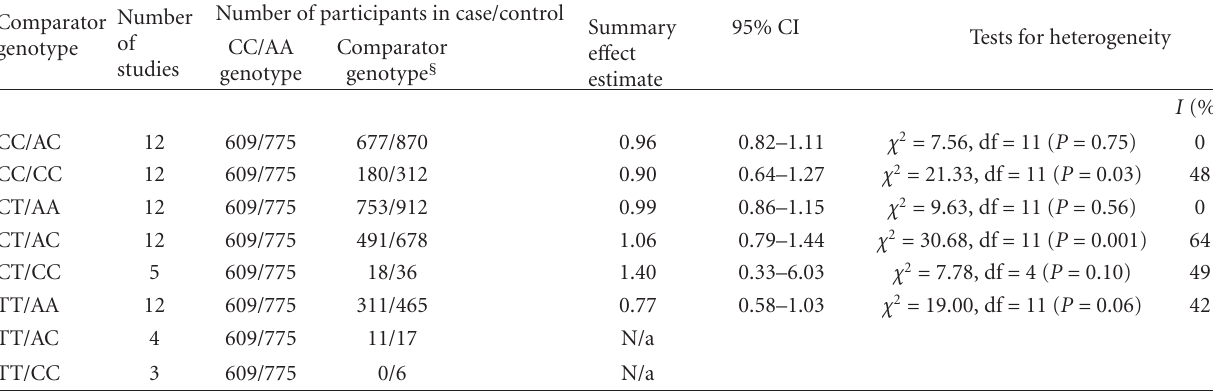
Table 4: Summary e ff ect estimate results for the MTHFR C677T and A1298C polymorphism